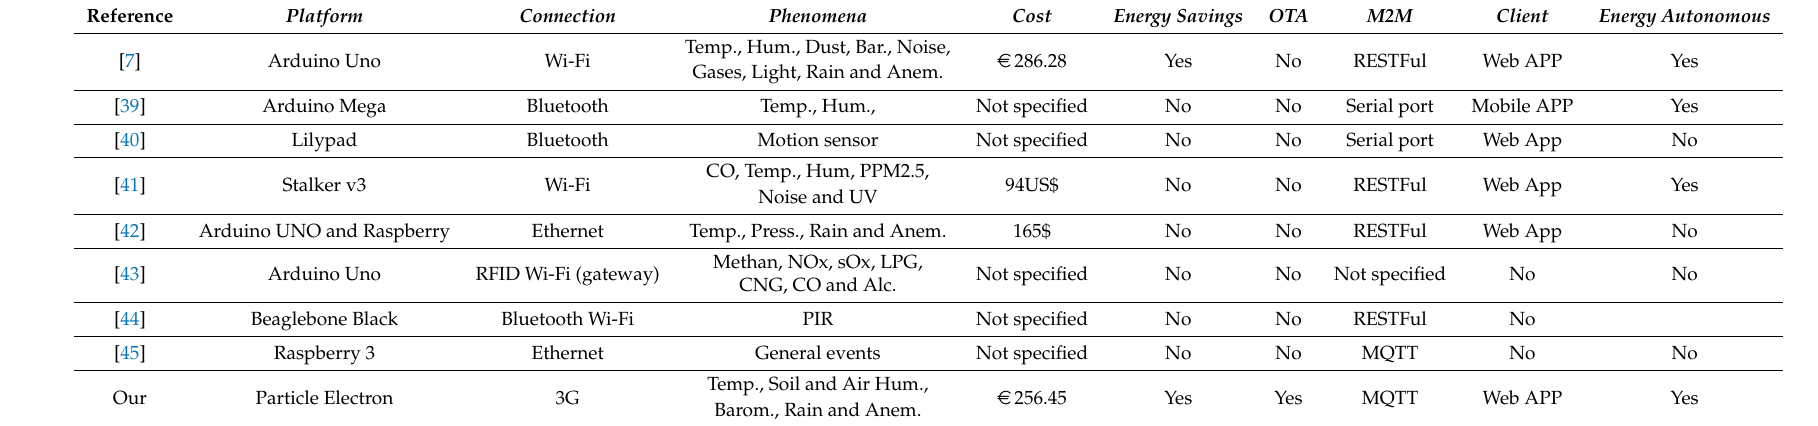
Table 11. Comparison between different sensorized